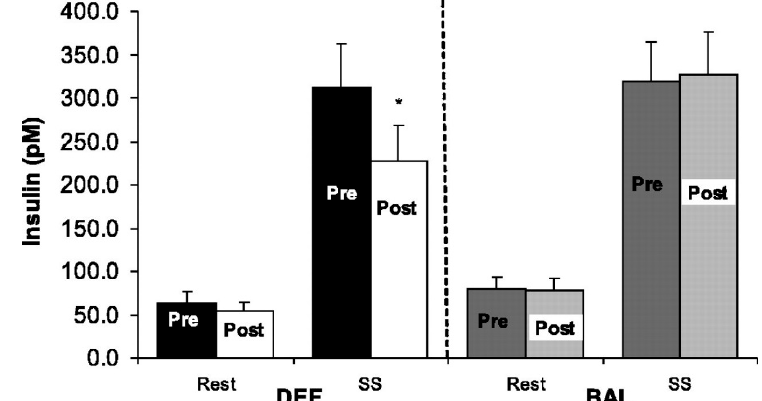
Figure 2. Change in resting and steady-state (SS) insulin concentrations in energy deficit (DEF) and energy balance (BAL). Values are means ± SE. * Significantly different from pretraining, p < 0.05. Reprinted with permission from the authors [22]; Copyright © 2005 the American Physiological Society. Table 1. Values are means ± SE.